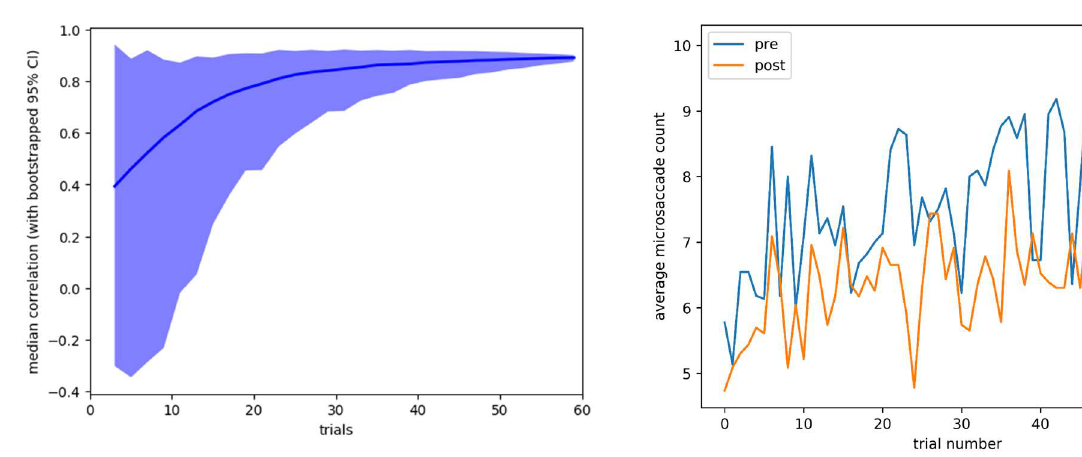
Figure 5: Average microsaccade count against trial number, pre and post caffeine